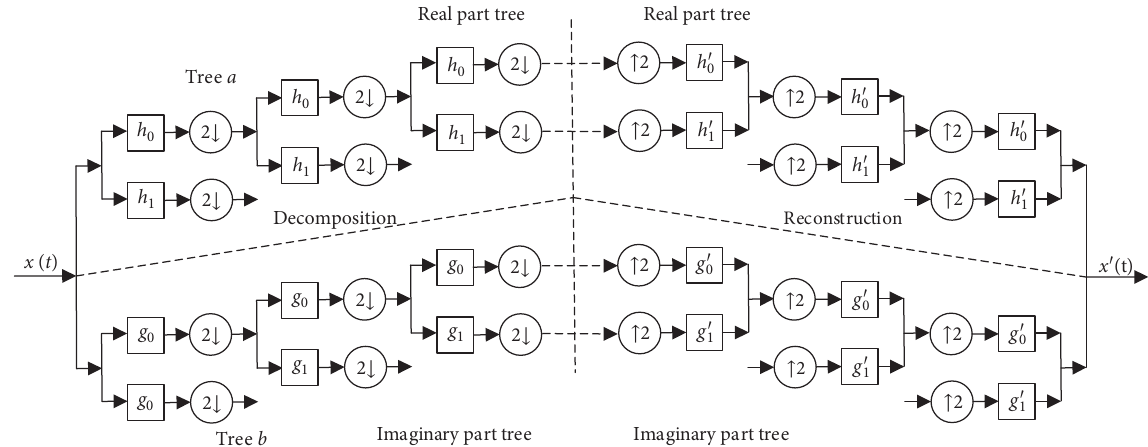
Figure 2: Decomposition and reconstruction of the DT-CWT.